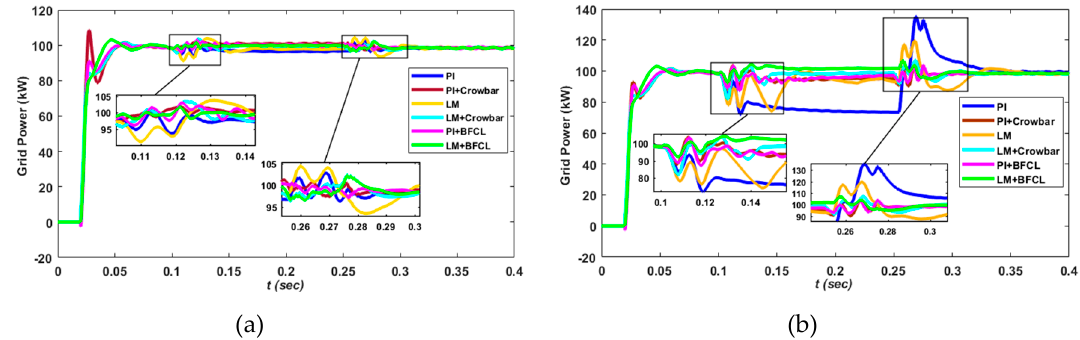
Figure 10. Grid real power response during the P-G fault 10( a ) and P-P fault 10( b ).